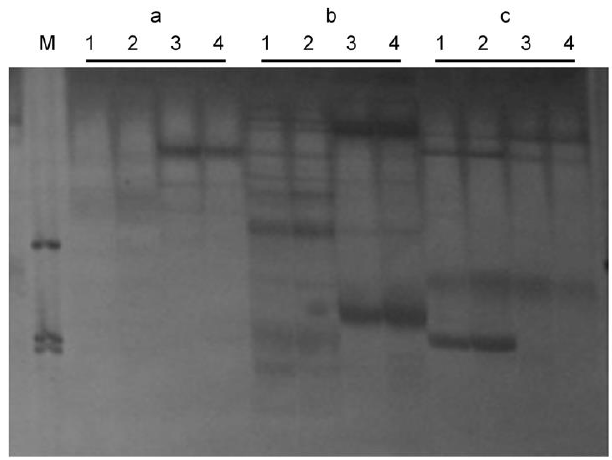
Figure 3. Polymorphism analysis of the partial ISSR markers in the parents and bulks. 1, M3290; 2, white flower bulk; 3, Qinghai12; 4, colored flower bulk. M, Marker (100 bp). a, ISSR7; b, ISSR12; c, ISSR36.